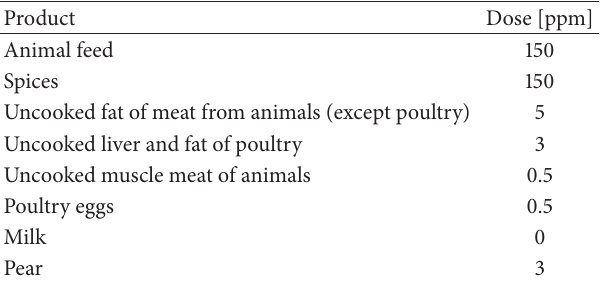
Table 1: Permitted amounts of EQ in different products approved by FDA ∗